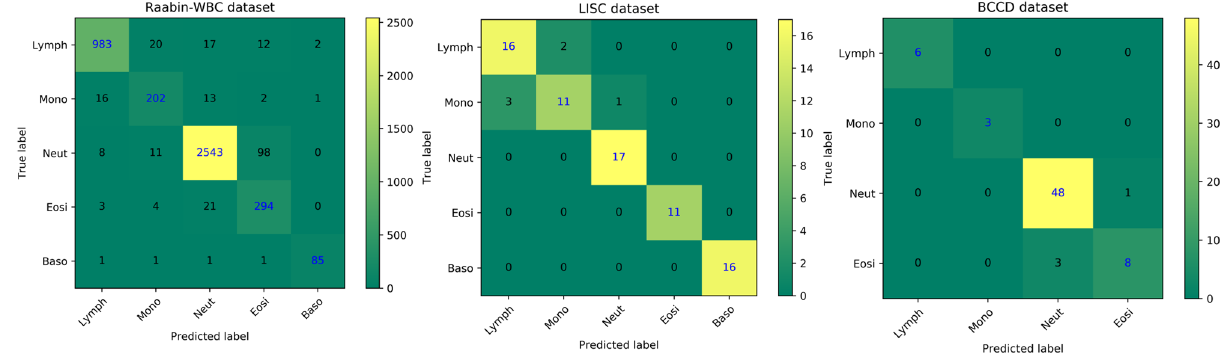
Figure 7. The confusion matrices of our proposed classification method for Raabin-WBC, LISC, and BCCD datasets.